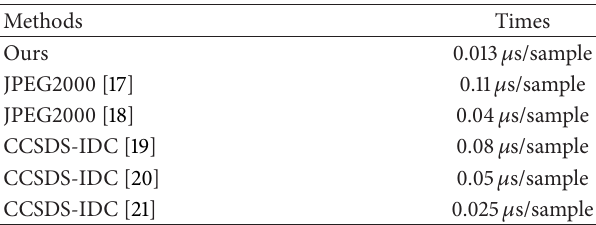
Table 1: The results of complexity comparison. Table 2: The occupancy of